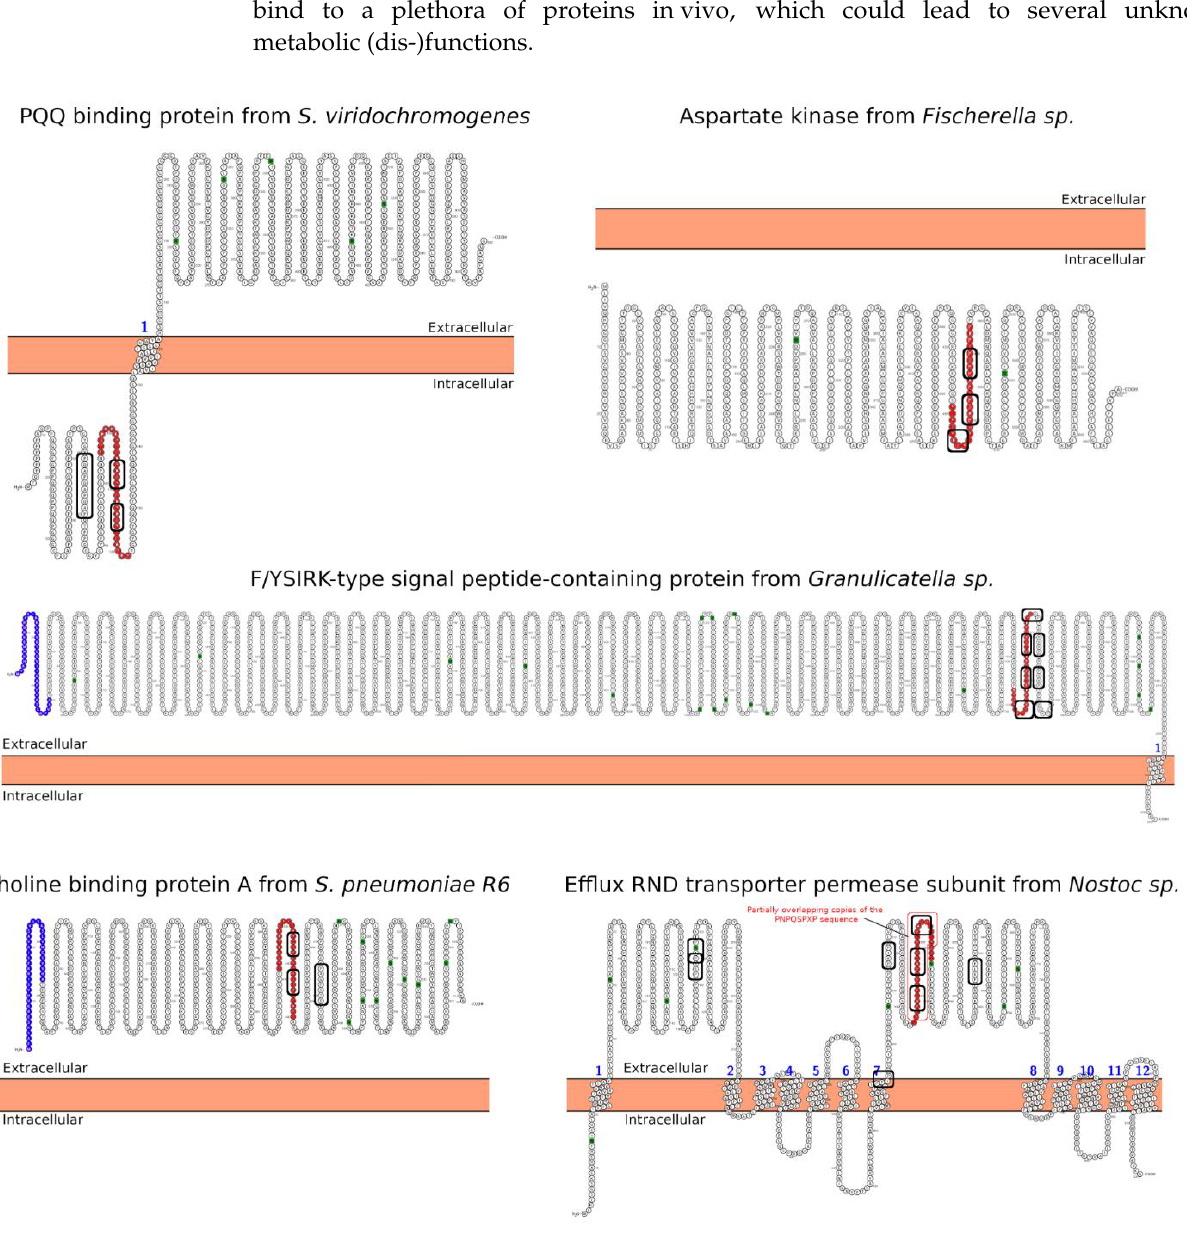
Figure 6. Predicted subcellular localization for the BLASTp hits proteins using the 33-mer sequence as query. The localization of the high similarity sequence regions from the five best BLASTp hits is shown in red. The SH3-binding motifs are highlighted with a rectangle. The analysis was performed using the Protter server [82]. The partially overlapping copies of the PNPQSPXP sequence in the RND efflux pump protein are shown as a red rectangle. The signal peptides are shown in blue and N-glycosylation motifs are marked as green squares.